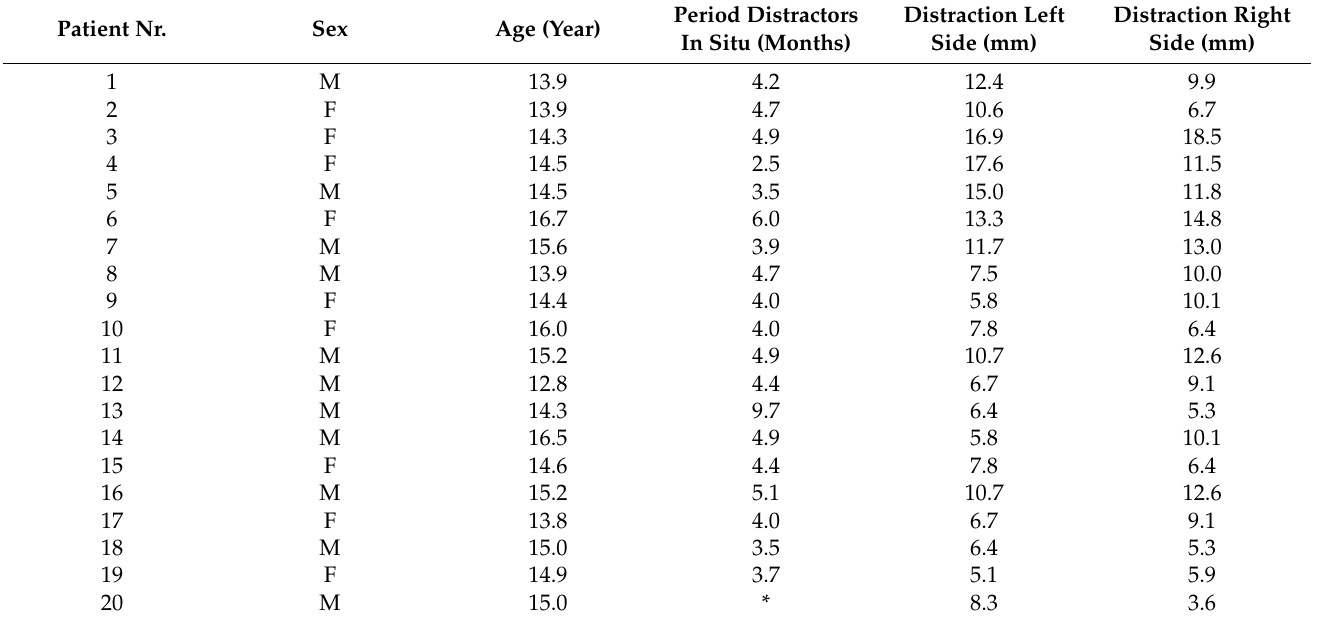
Table 1. Patient